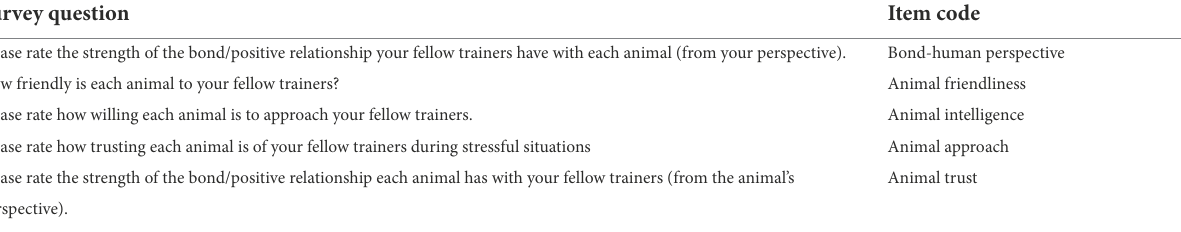
TABLE 2 Survey items for peer ratings of animal bonds. Survey